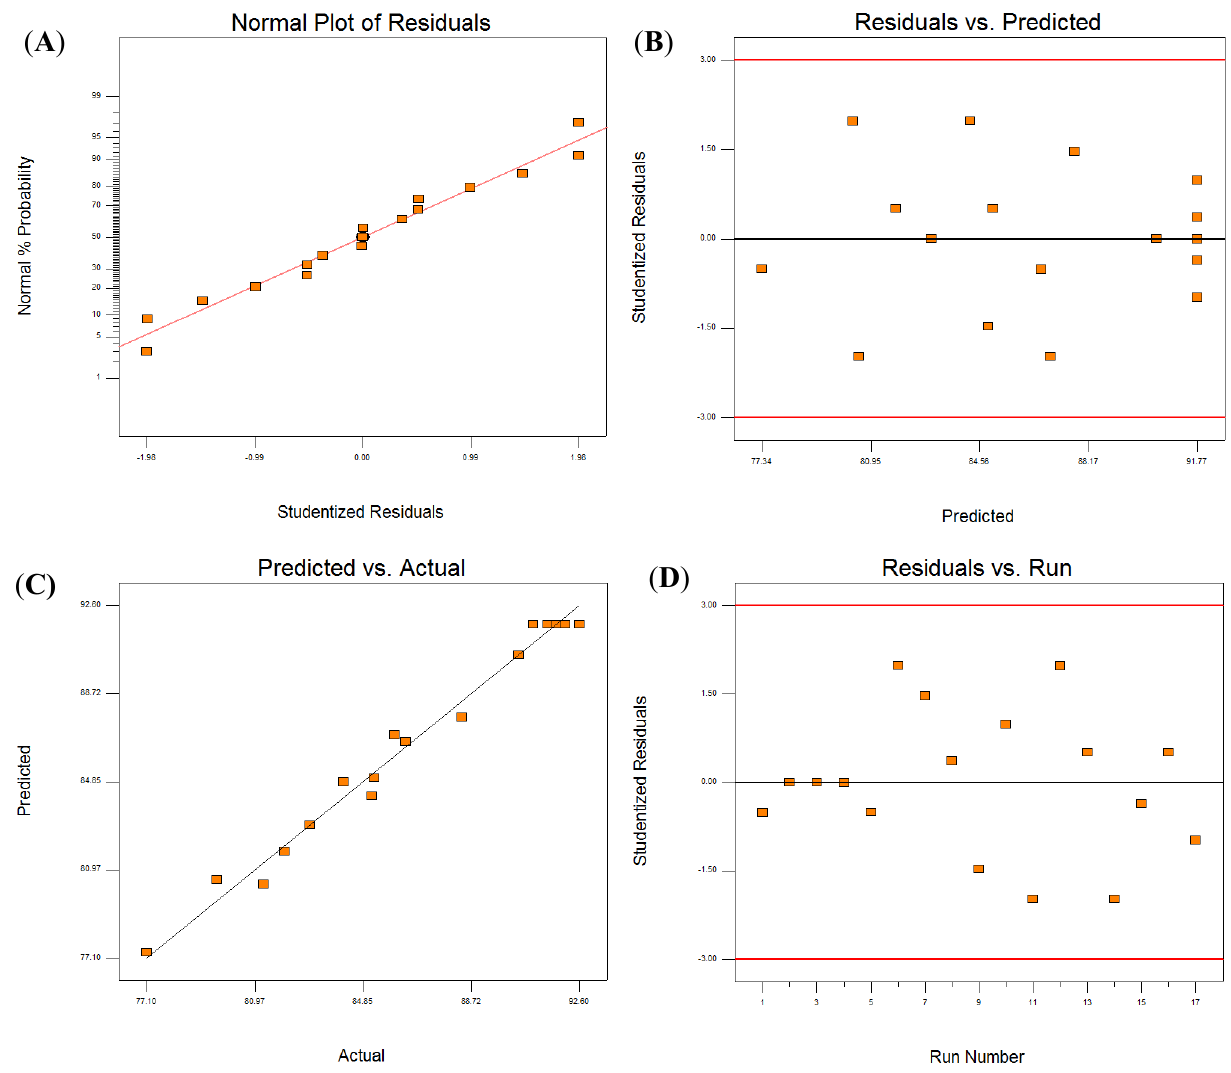
Figure 2. Analysis of RSM model: ( A ) Normal Plot of Residuals; ( B ) Residuals vs . Predicted; ( C ) Predicted vs . Actual; ( D ) Residuals vs .